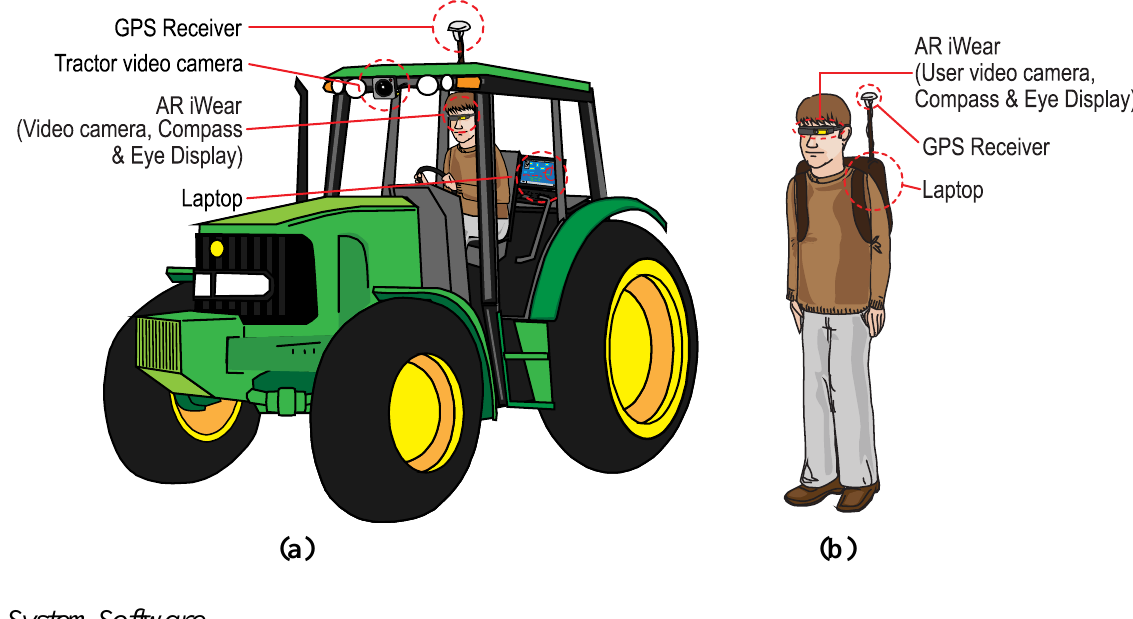
Figure 1. Hardware of the system. (a) “Tractor equipment”, the hardware of the system when the user is inside the tractor cab. (b) “Exterior equipment”, the hardware of the system when the tractor driver is outside the tractor